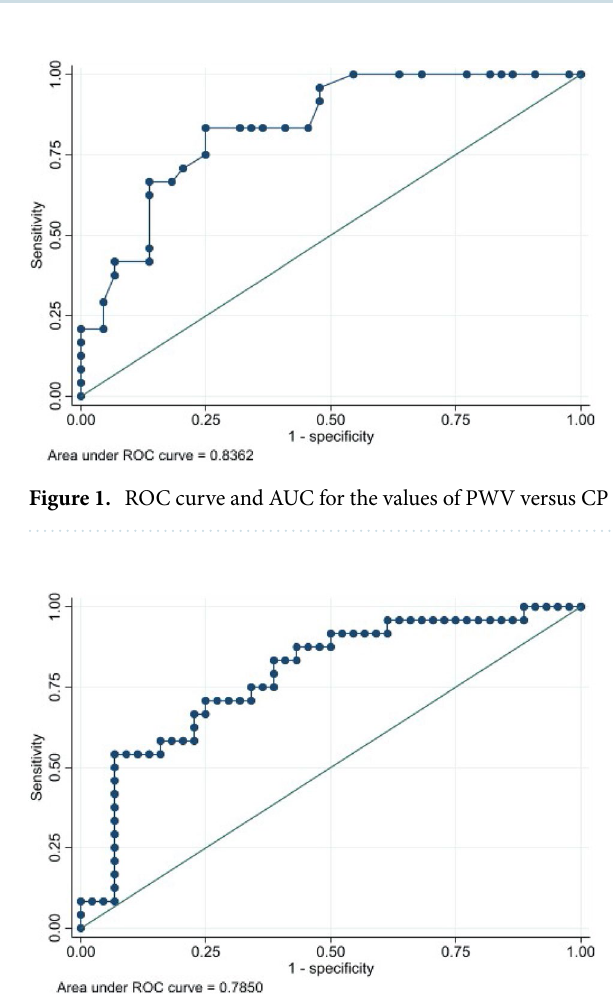
Figure 2. ROC curve for the values of sclerostin versus CP status.